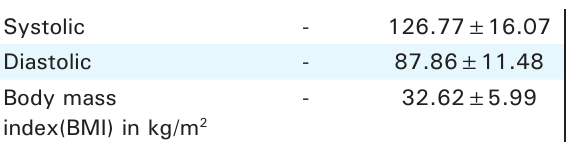
diastolic hypertensive, body mass index, diabetes higher in microalbuminuria group compared with characteristics were similar in both groups.